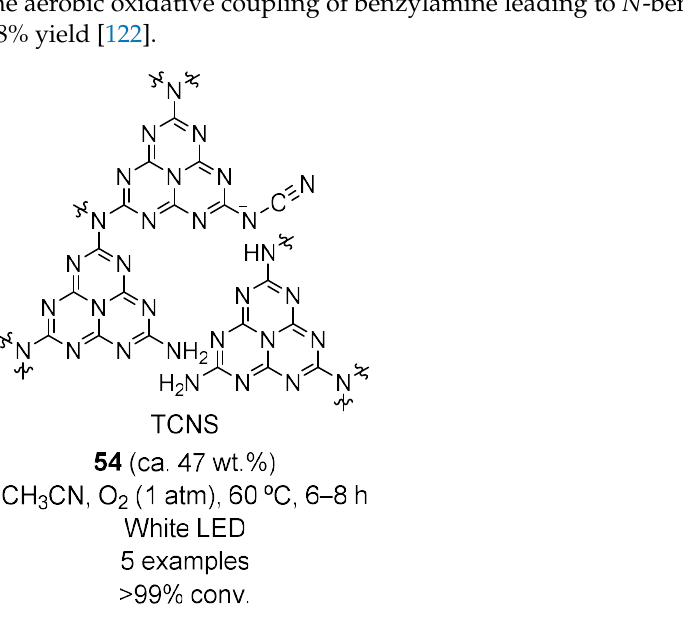
Figure 11. Results obtained in the aerobic photo-oxidative coupling of benzylamines to N -benzylidene benzylamines 2 catalyzed by 54 .